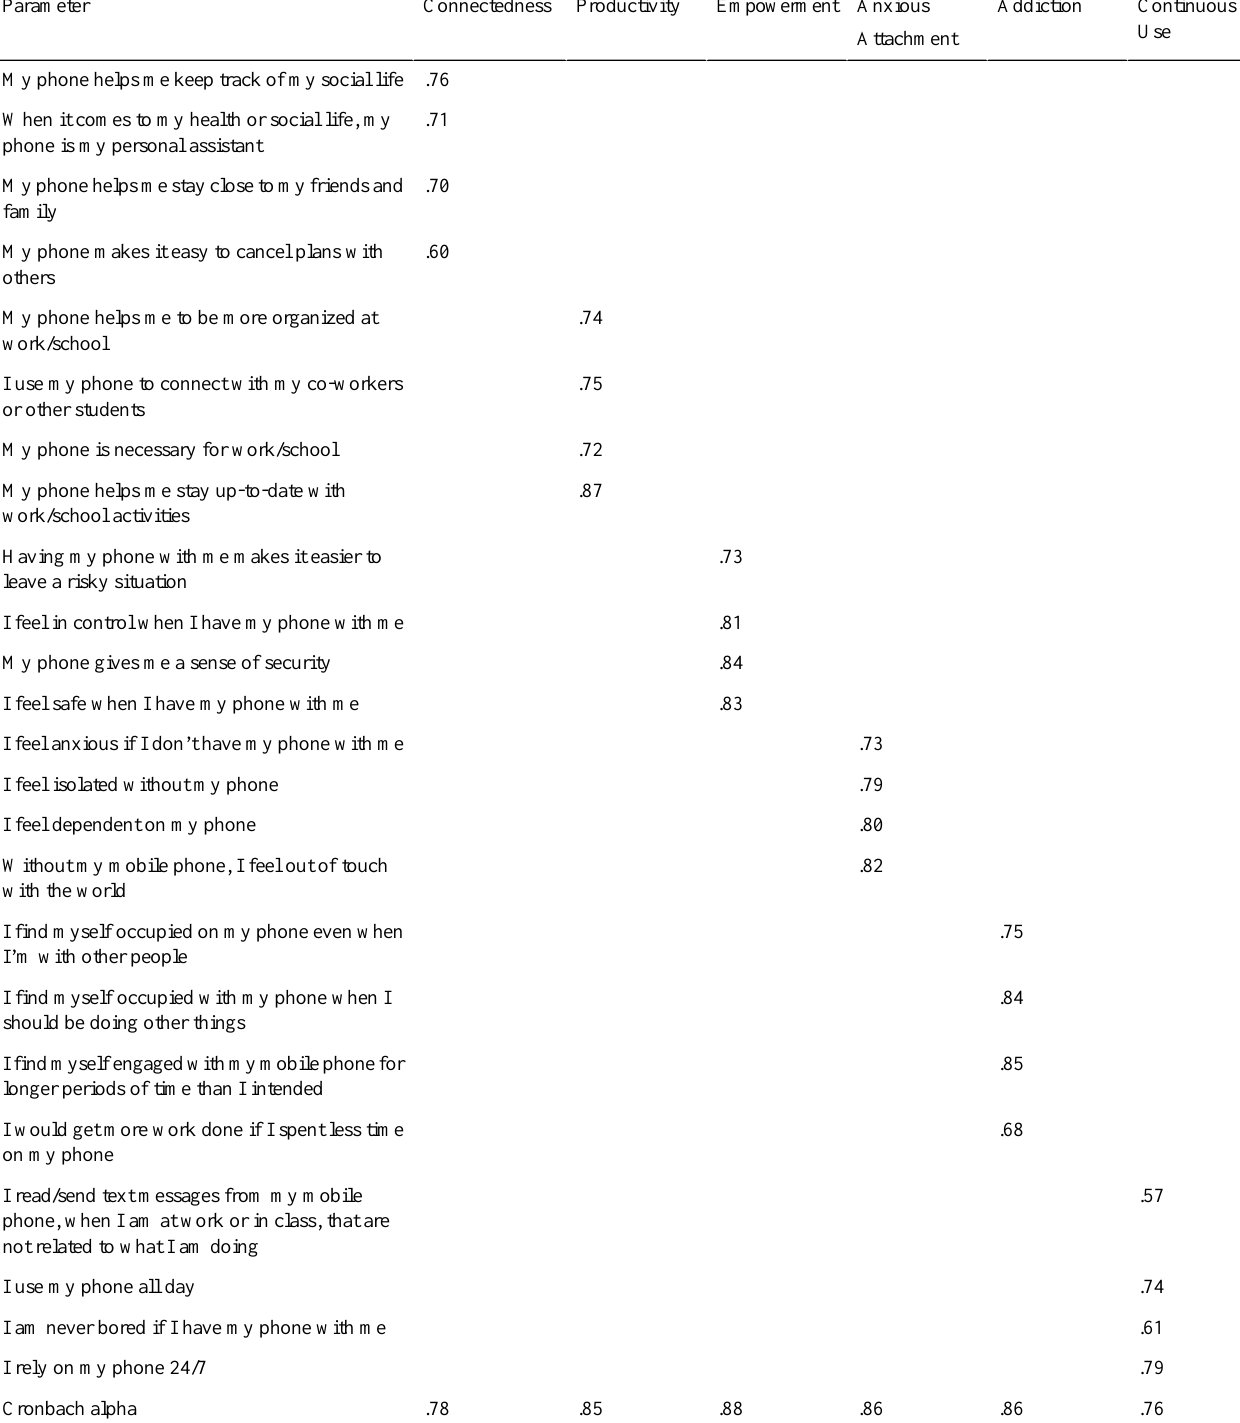
Continuous UseAddictionAnxious